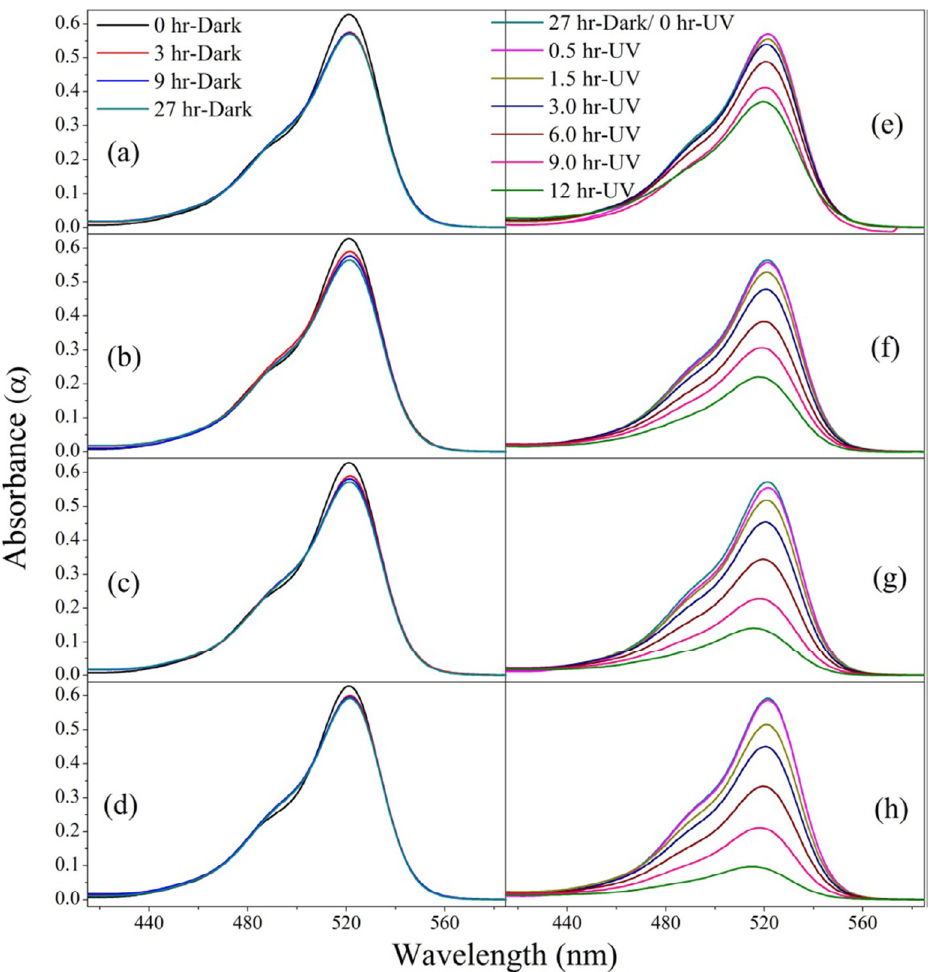
Figure 6. ( a – d ) UV absorption spectra for the photocatalysis of rhodamine 6G under dark and ( e – h ) under UV irradiation on 0%, 5%, 10%, and 15% cement–ZnO(%) composites. Ref.